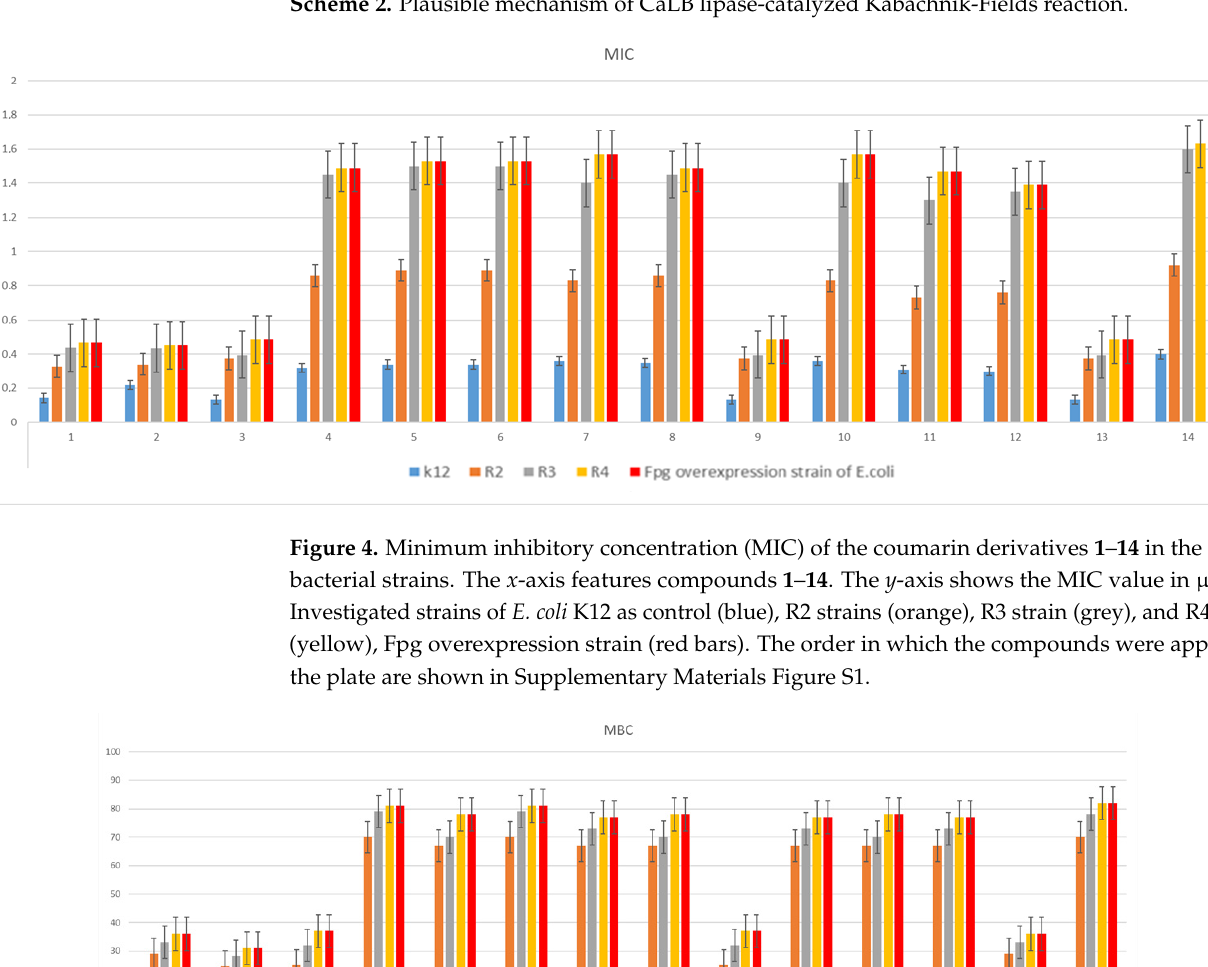
Scheme 2. Plausible mechanism of CaLB lipase-catalyzed Kabachnik-Fields reaction.